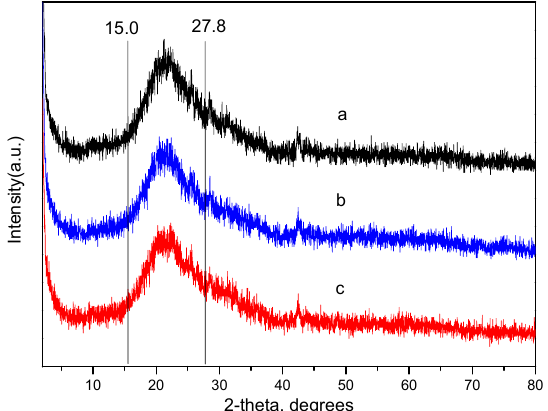
Figure 3. XRD patterns of catalysts ( a ) catalyst 1, ( b ) catalyst 2, ( c ) catalyst 3.